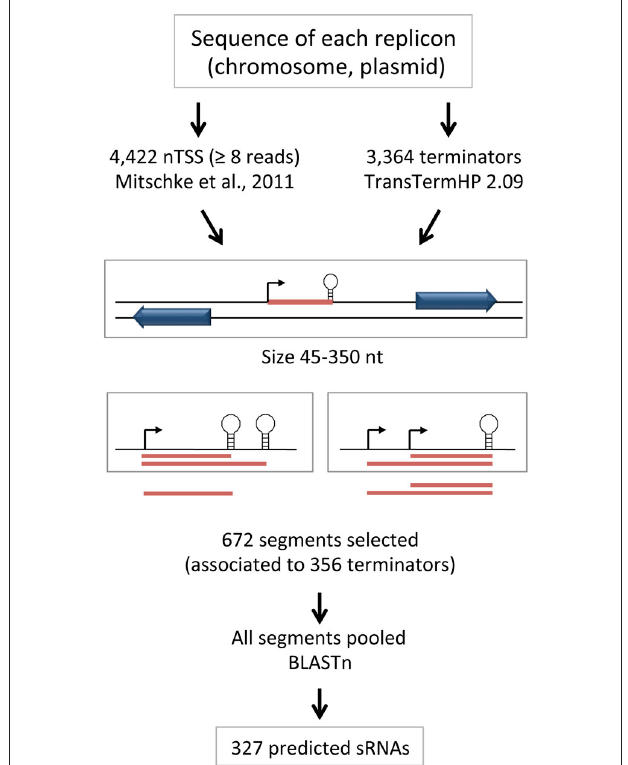
FIGURE 1 | Outline of the procedure used for prediction of sRNAs. The approach for initial selection of segments potentially corresponding to sRNAs and the decisions taken in cases where several predicted terminators can be associated to one single TSS or multiple TSS can be associated to one single predicted terminator are